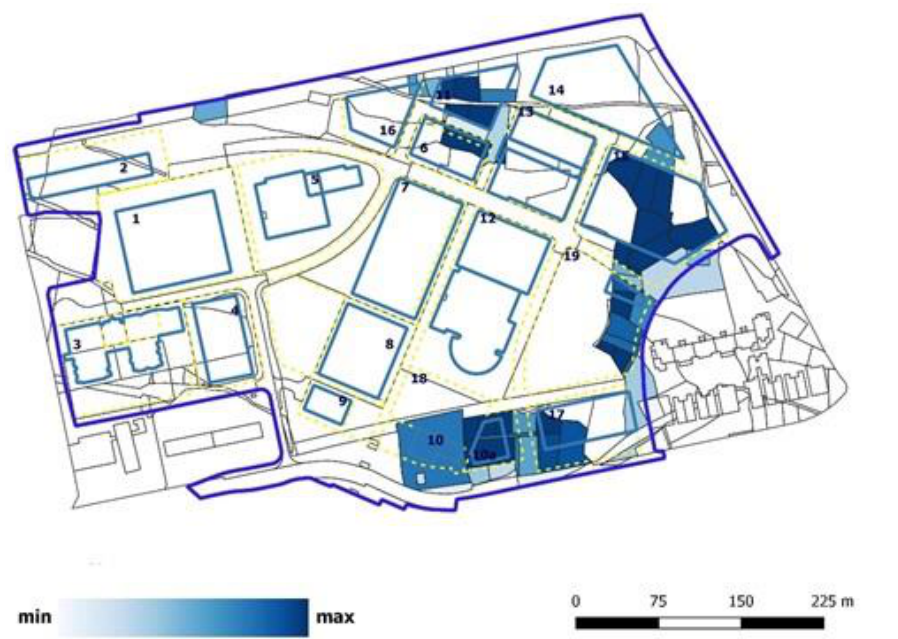
Figure 5. Intended utility assessment of private cadastral parcels in the Campus project, University of Split.